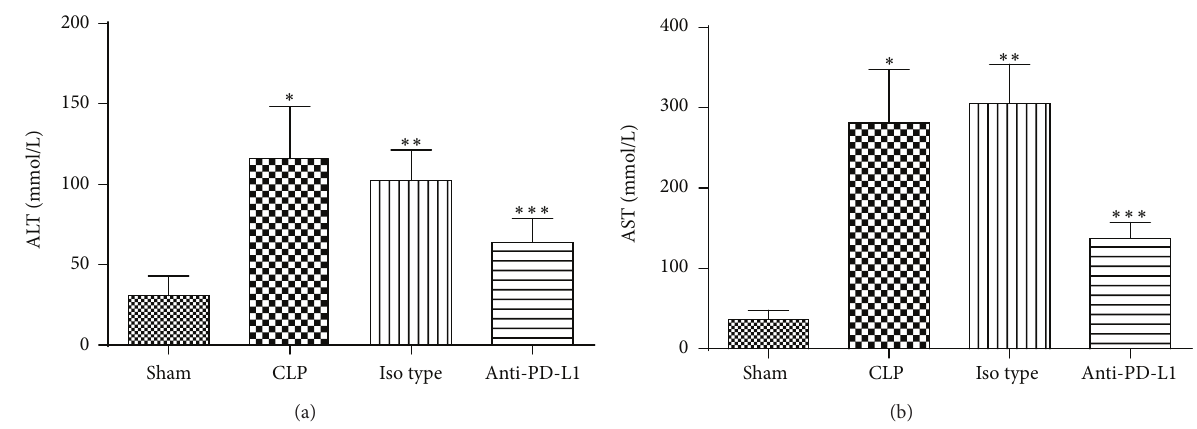
Figure 5: Anti-PD-L1 antibody treatment improved liver function of septic mice. 𝑛 = 8 per each group. ∗ 𝑃 < 0.01 when mice from CLP group were compared with mice from Sham group; ∗∗∗ 𝑃 < 0.01 when mice from Anti-PD-L1 group were compared with mice from CLP group; ∗∗ 𝑃 > 0.05 when mice from Iso-type group were compared with mice from CLP group. Bars represent the mean ± SD.